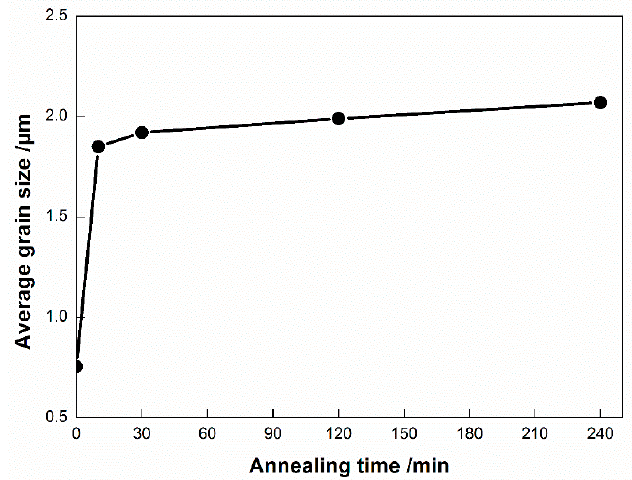
Figure 9. Grain size evolution under different annealing times.